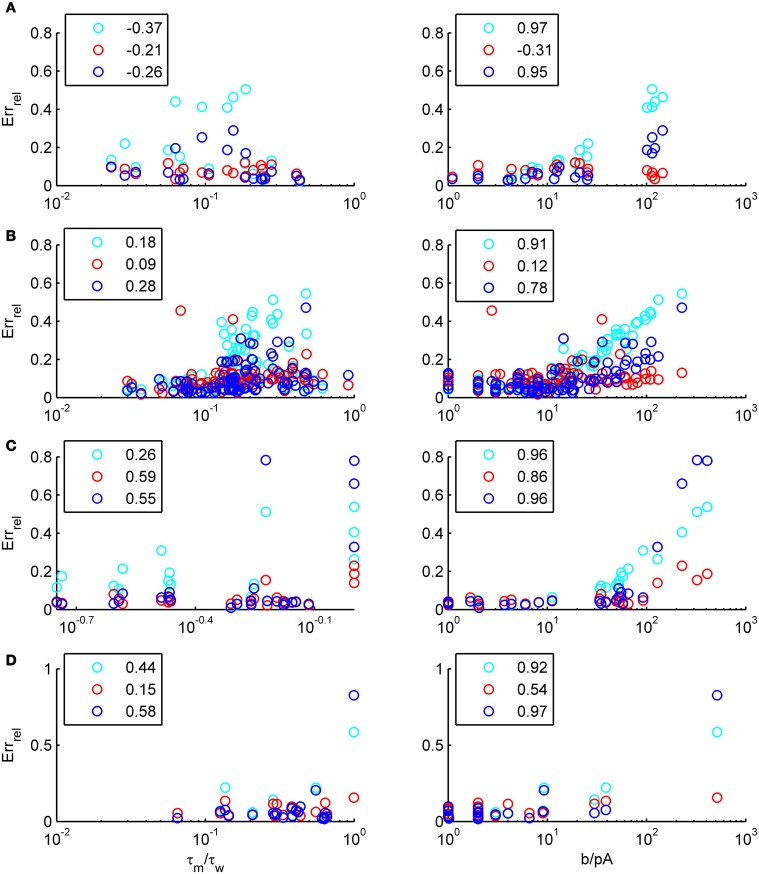
The relative prediction error for the full FP, the EIF-〈w〉 and the EIF-F(w) approach as function of model parameters. The error is shown as a function of τm/τw(left) and b (right) for layer-3 pyramidal cells (A), layer-5 pyramidal cells (B), fast-spiking (C) and bitufted (D). cyan: EIF-〈w〉, blue: full FP, red: EIF-F(w). Pearson correlations are given in the legends. Error averaged over σIsyn ∈ {100, 200, 300, 400, 500, 600} pA and μIsyn = cell-specific rheobase.